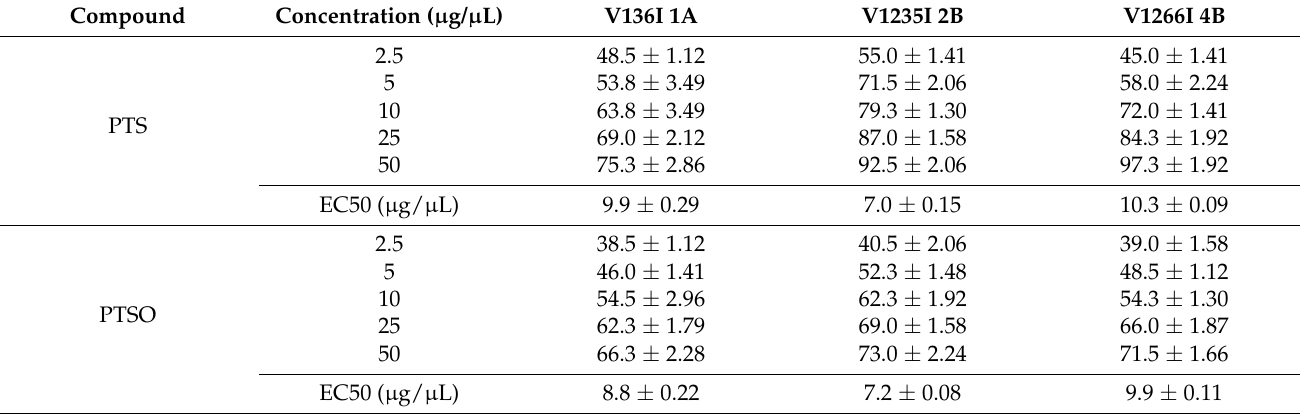
Table 4. In vitro antifungal activity of PTS and PTSO against different isolates of Verticillium dahliae (V136I 1A, V1235I 2B and V1266I 4B) via the gas phase, expressed as the average diameter ± standard deviation of inhibition zone (mm), and EC50 values.